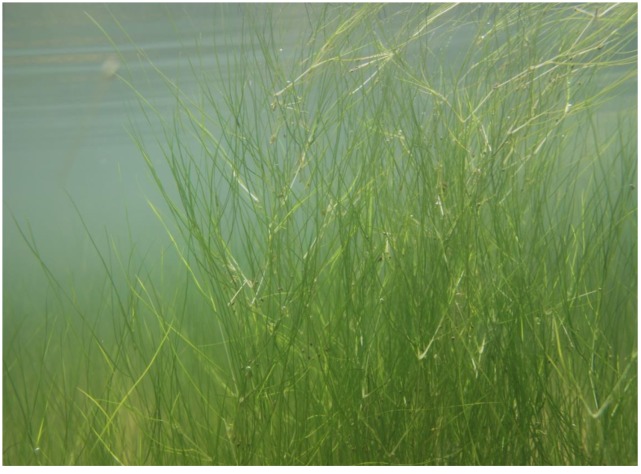
The natural status of Ruppia sinensis population in the Dongying area.